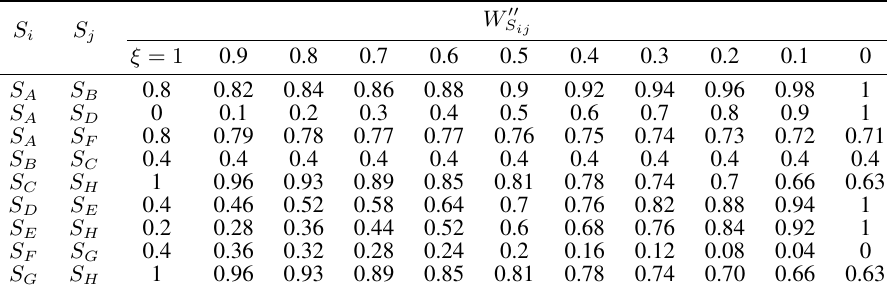
) based on Equation 3. S ij